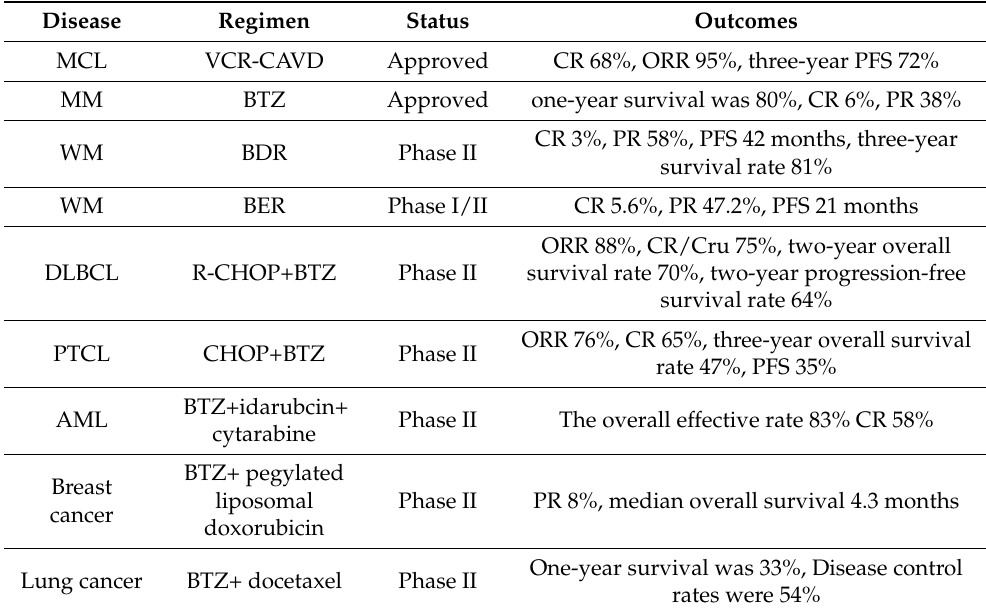
Table 2. The application of BTZ in clinics and clinical trials.